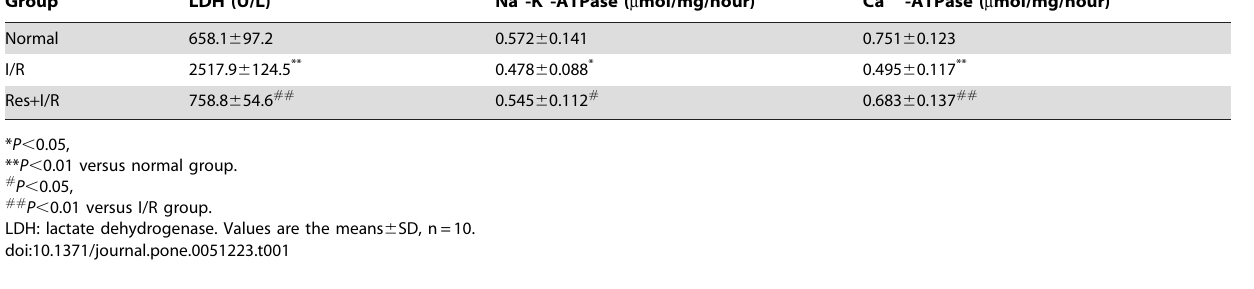
Group LDH (U/L) Na + -K + -ATPase ( m mol/mg/hour) Ca 2 + -ATPase ( m mol/mg/hour) Normal 658.1 6 97.2